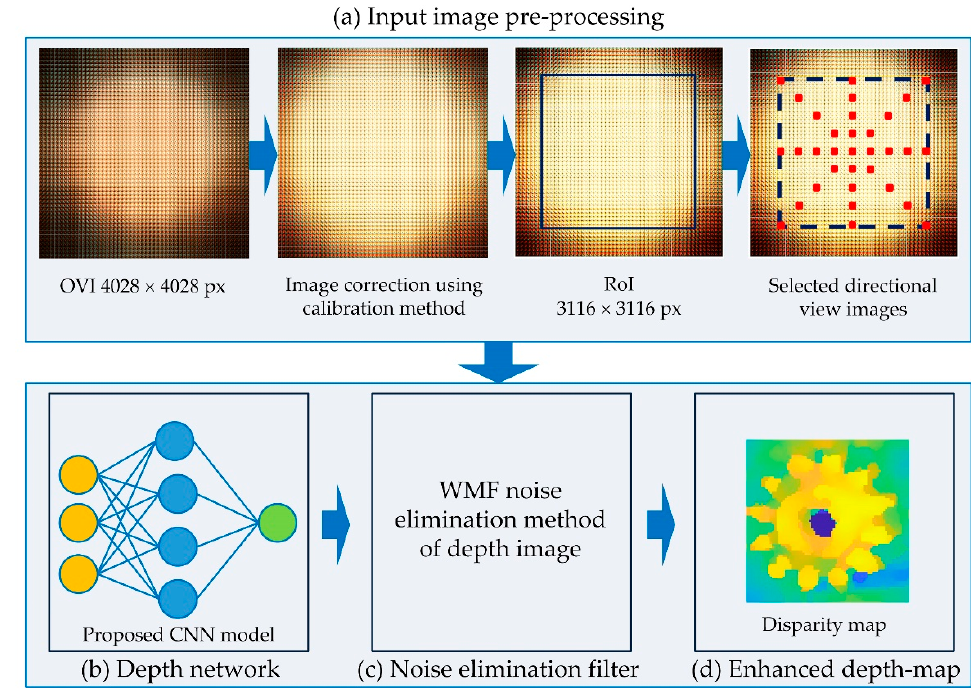
Figure 2. An illustration of the proposed IIM depth enhancement method.